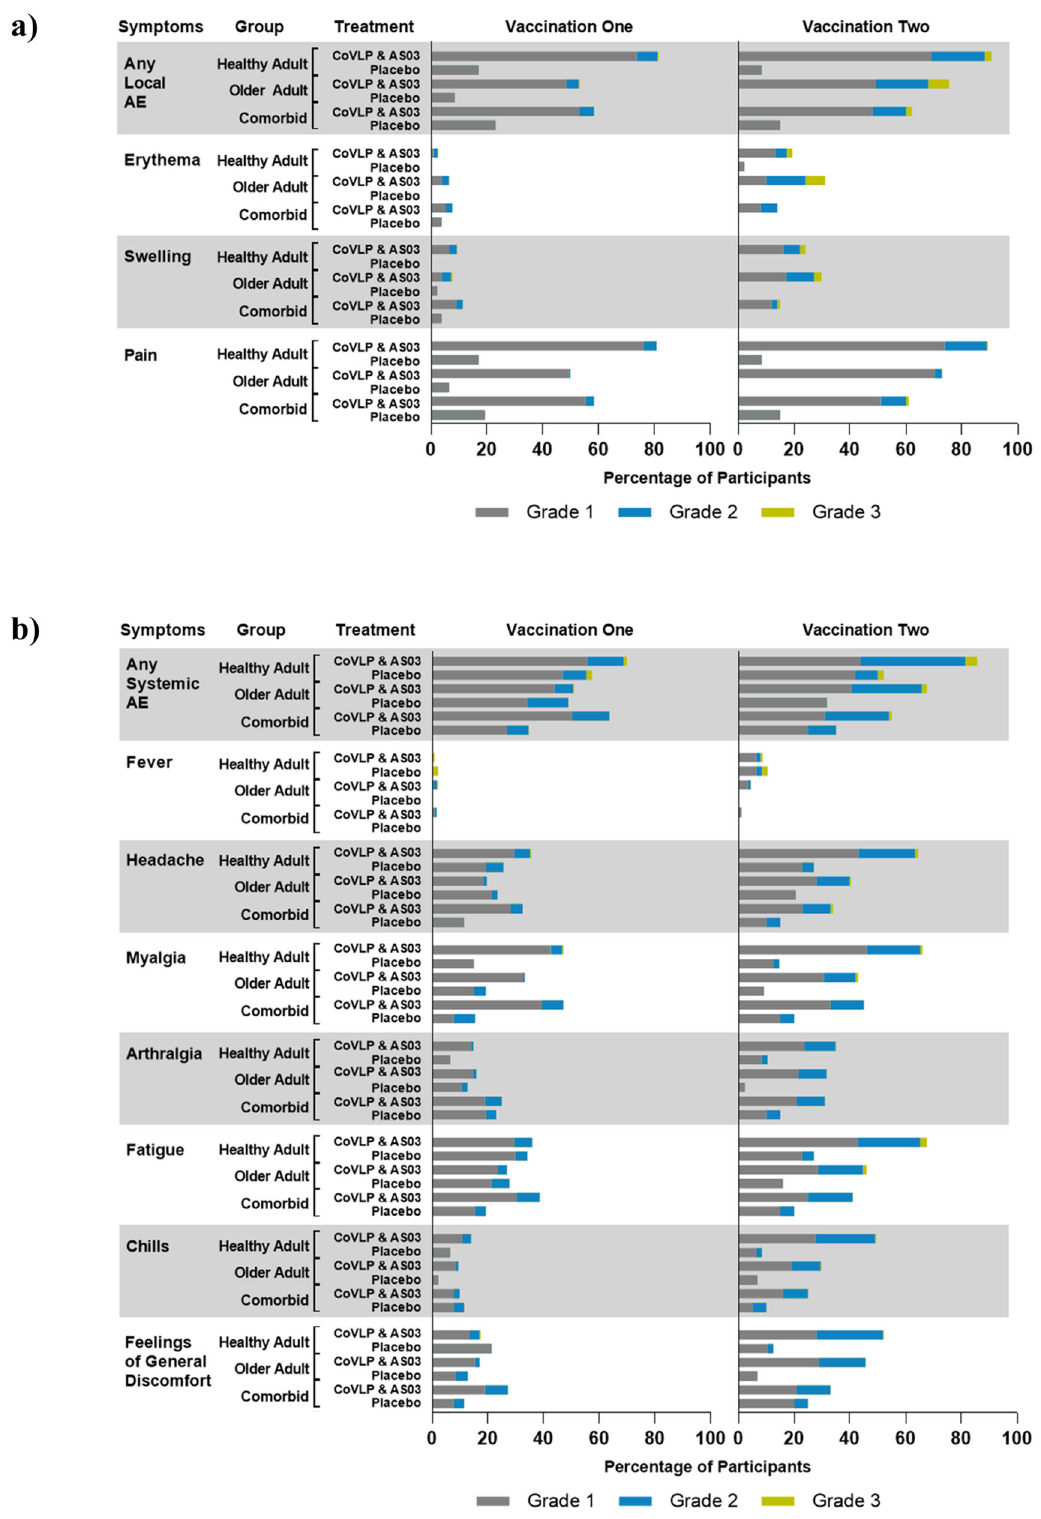
Fig. 2 Solicited local and systemic adverse events 7 days after the fi rst or second vaccine candidate dose. Participants were monitored for solicited local (panel a ) and systemic (panel b ) AEs from the time of vaccination through 7 days after administration of each dose. No Grade 4 (potentially life-threatening) events were reported. Participants who did not report AEs make up the remainder of the 100% calculation (not shown). If any of the solicited AEs persisted beyond 7 days after each vaccination (when applicable), it was recorded as an unsolicited AE. Fever was de fi ned as oral temperature ≥ 38.0